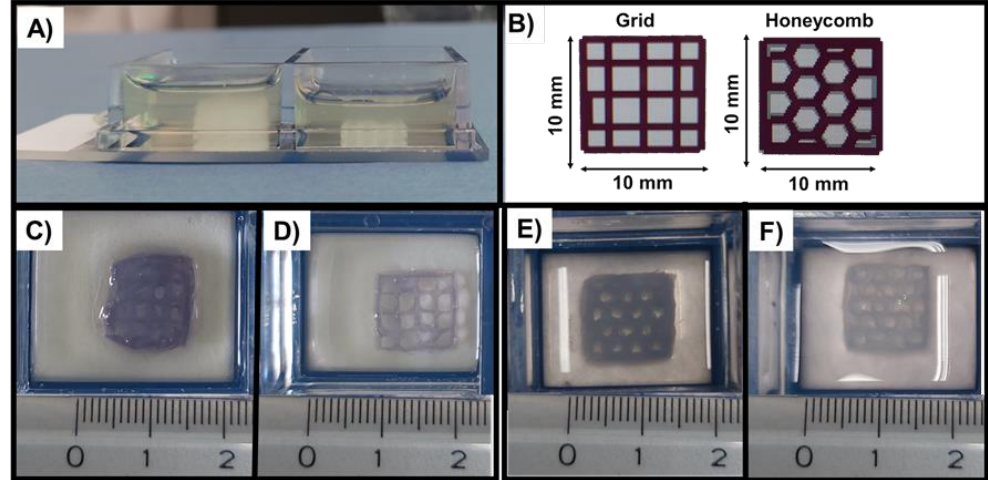
Figure 9. Images of 15 wt.% Alginic acid bath ( A ), scaffold design ( B ) and printed scaffolds after incubation at 37 °C for 24 h: GEN-Coll/MBG_Sr4%, T1 and T2 ( C , D , respectively) and GEN-Coll/nanoHA, T3 and T4 ( E , F , respectively). Blue coloration of scaffolds is indicative of genipin crosslinking. Scaffold measurement 10 × 10 × 1 mm.